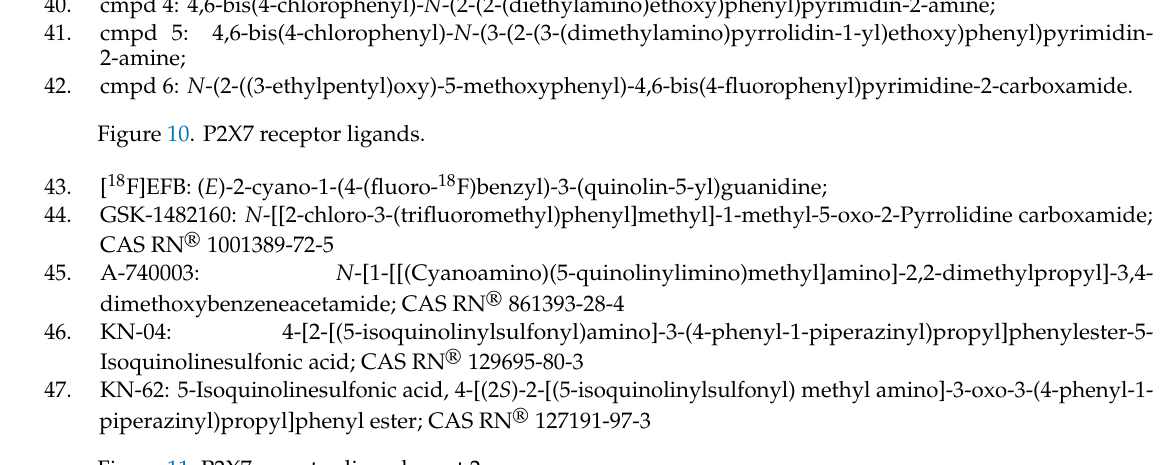
Figure 11, P2X7 receptor ligands part